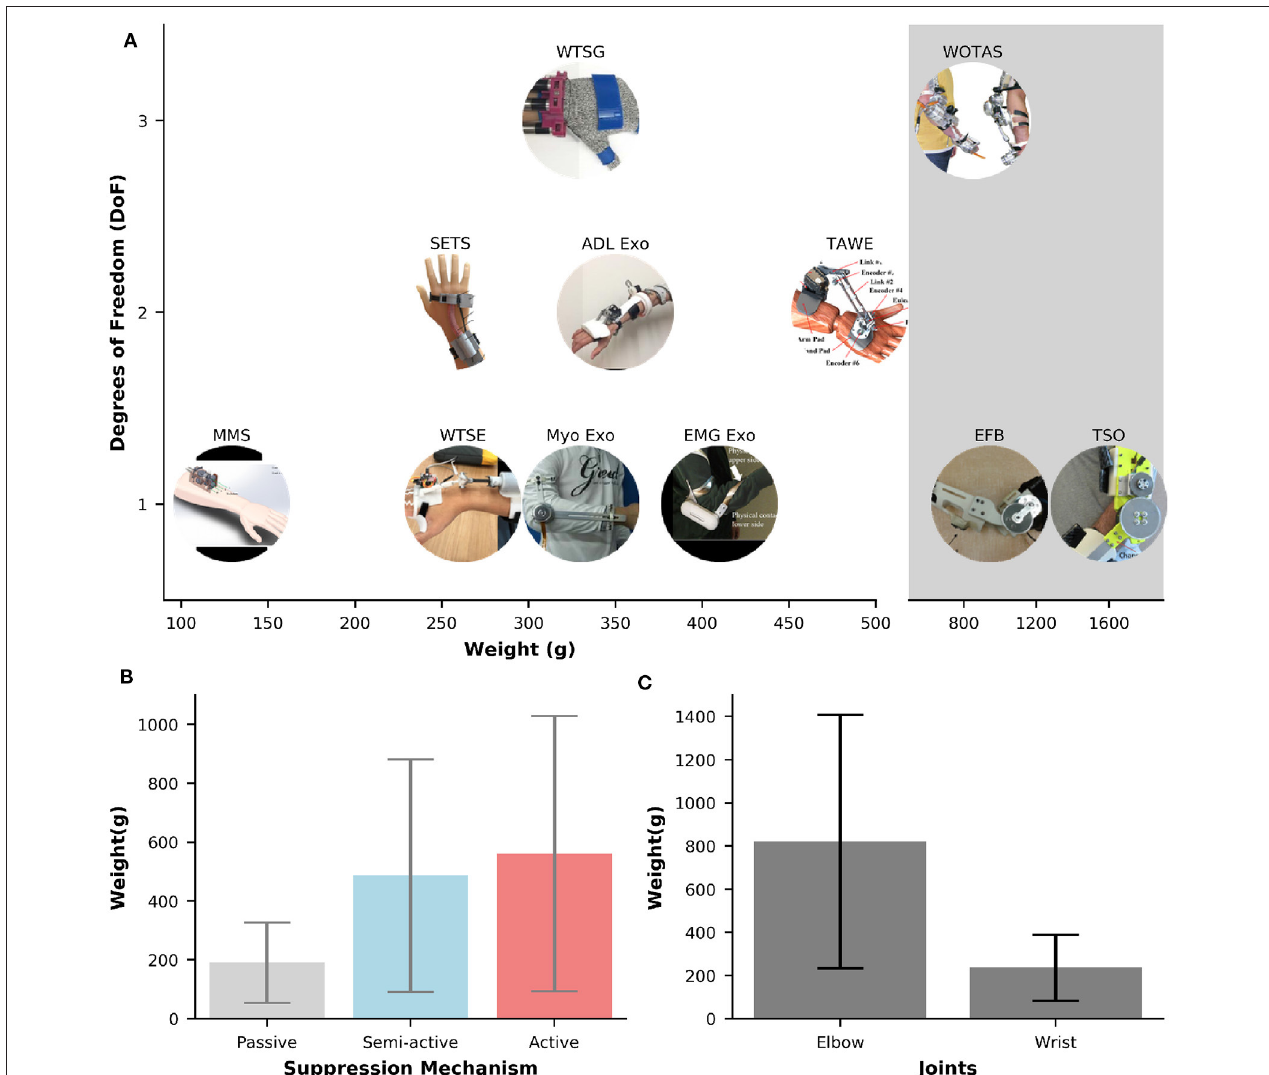
FIGURE 4 | (A) Overview of weights and numbers of DOF for semi-active and active orthoses. The shaded gray area represents the systems that weight larger than > 850 g. (B,C) Bar plots of weights against different suppression mechanisms and joints, respectively. Error bars represents one standard